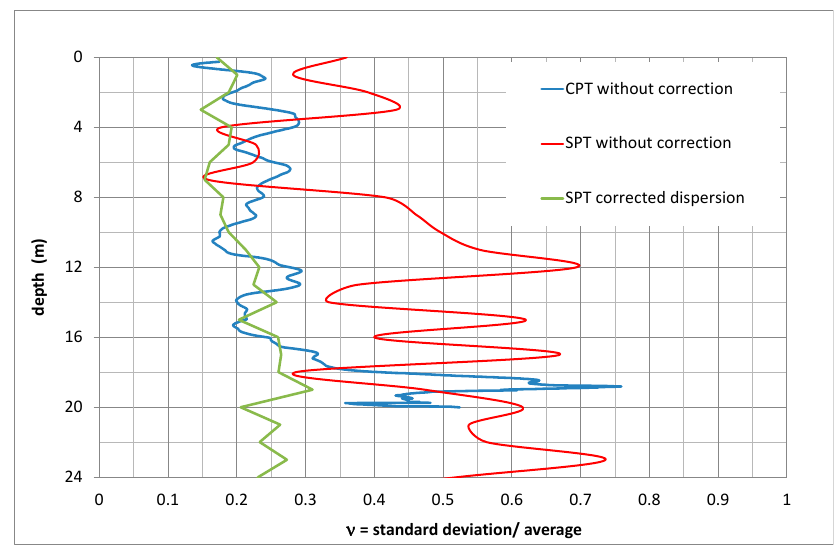
Figure 2. Dispersion with SPT corrected by method uncertainty.